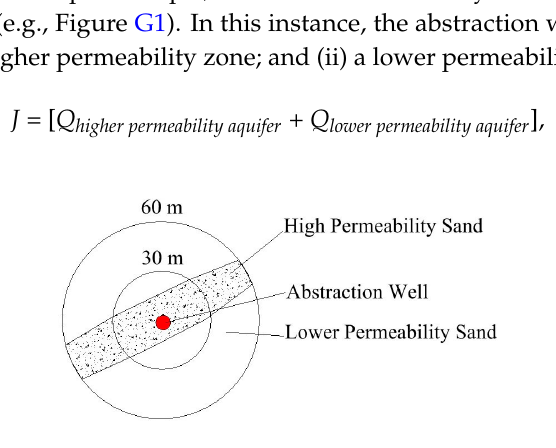
Figure G1. Schematic plan view of a schematic aquifer showing the 60 m radius of the treatment zone, abstraction well, and the distribution of the lower and higher permeability sand